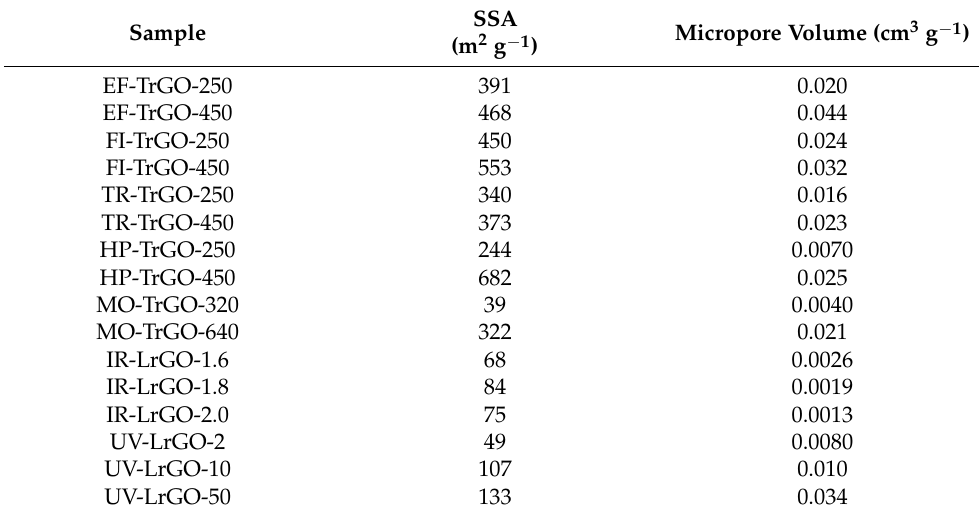
Table 3. Textural characterization of TrGO and LrGO